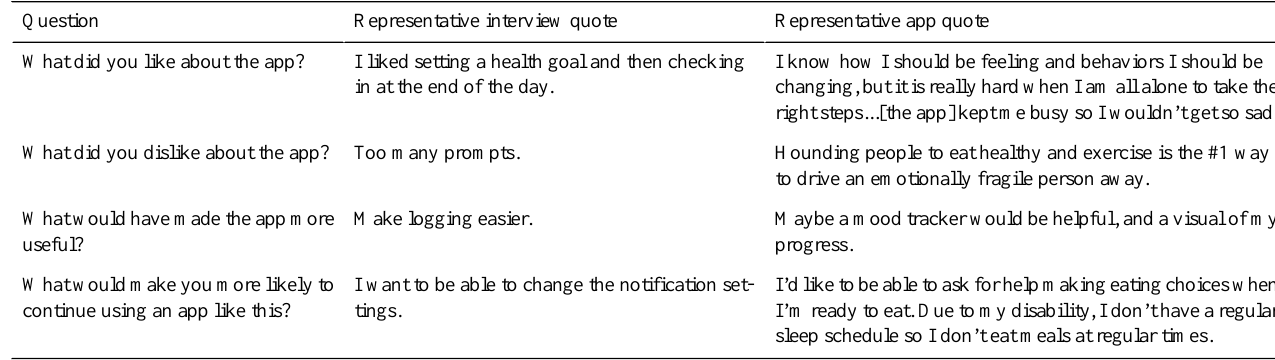
Table 3. Postparticipation interview responses vs app-collected